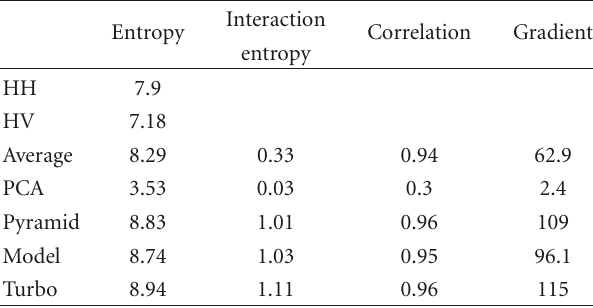
Table 2: Evaluation of fusion